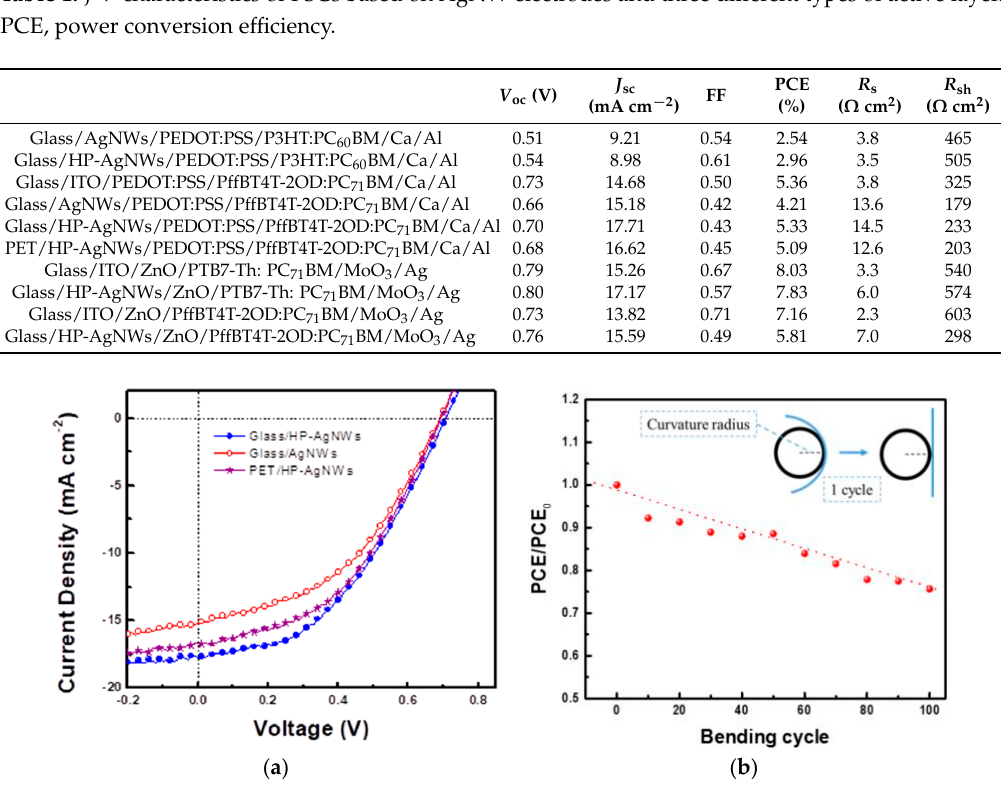
Figure 3. ( a ) J - V curves of PSCs based on PffBT4T-2OD:PC 71 BM using different electrodes; ( b ) bend test of the flexible PSCs (curvature radius = 2 cm; bend test value = 100 times); the inset shows the schematic of the bend test. Table 1. J - V characteristics of PSCs based on AgNW electrodes and three different types of active layer. PCE, power conversion efficiency.